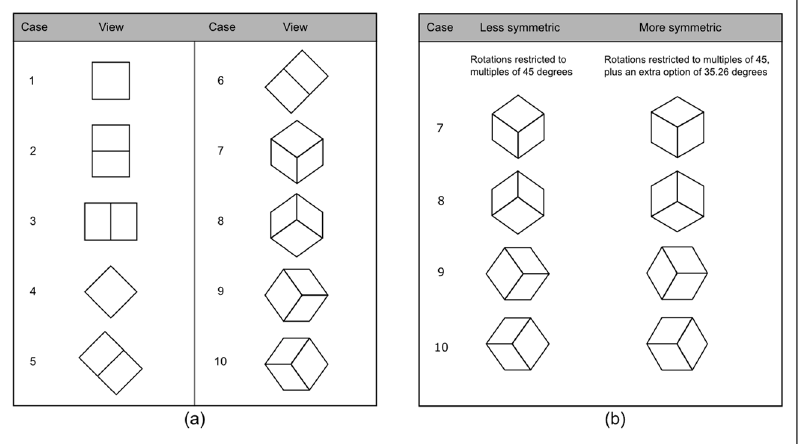
Figure 7. Restrictions placed on symmetric views: ( a ) Chosen views with rotations only in multiples of 45 degrees; ( b ) Comparison of loss of symmetry in four views (7, 8, 9, and 10).